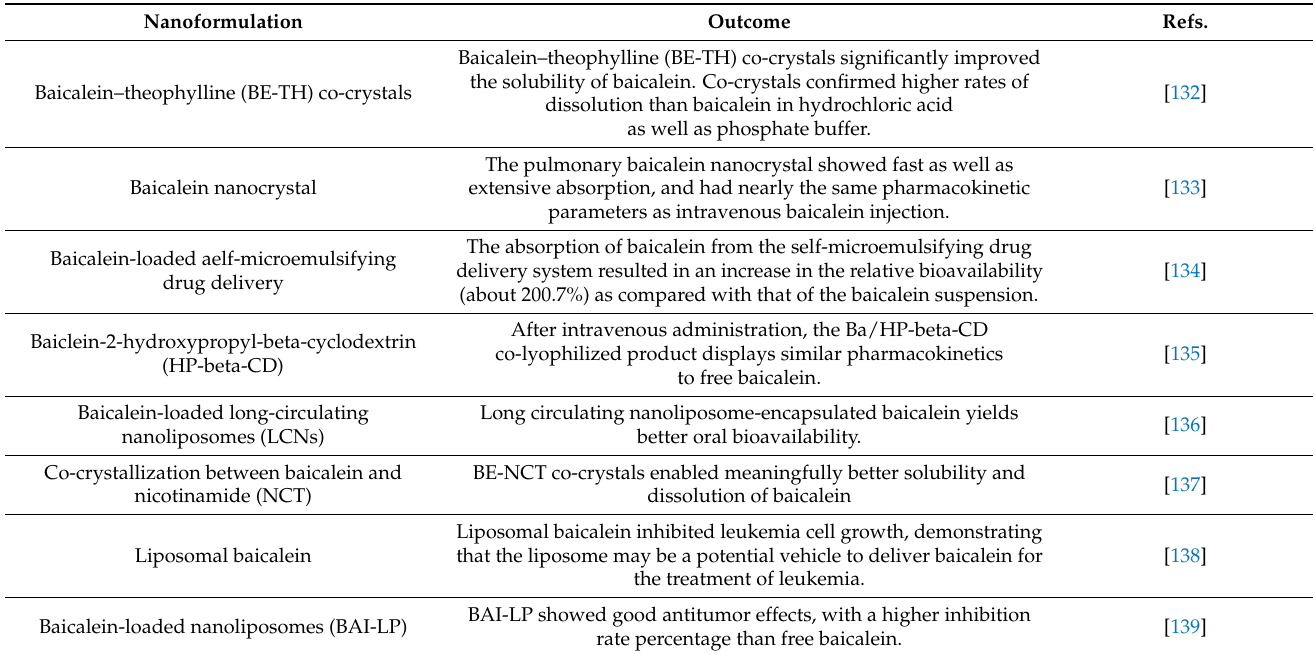
Table 3. Strategies to improve baicalein